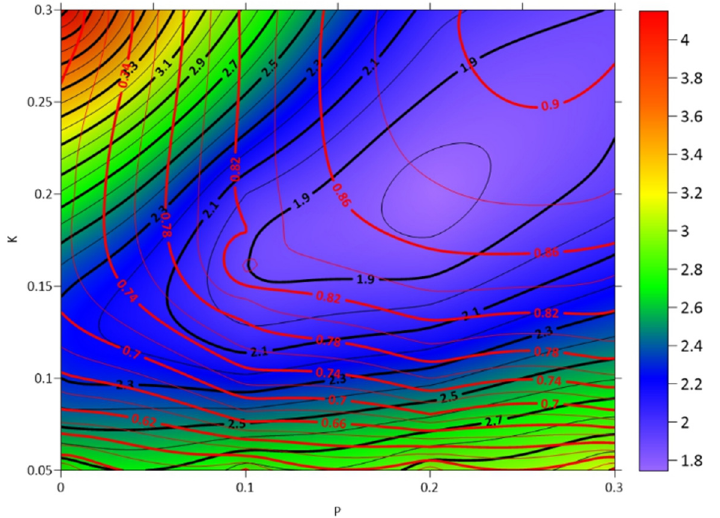
Figure 16. Superimposition of the RMSE surface (black contour lines) and the R 2 surface (red contour lines) for the monthly LDR-equivalent climate. The x -axis is the groin permeability P , while the y -axis is the GENESIS transport coefficient K . Surfaces were obtained by comparing the “measured” and “predicted” LRR functions of each K – P scenario. Table 3. Performance indices ( RMSE , R 2 , and mean µ ) for the monthly LDR-equivalent climate. P K R